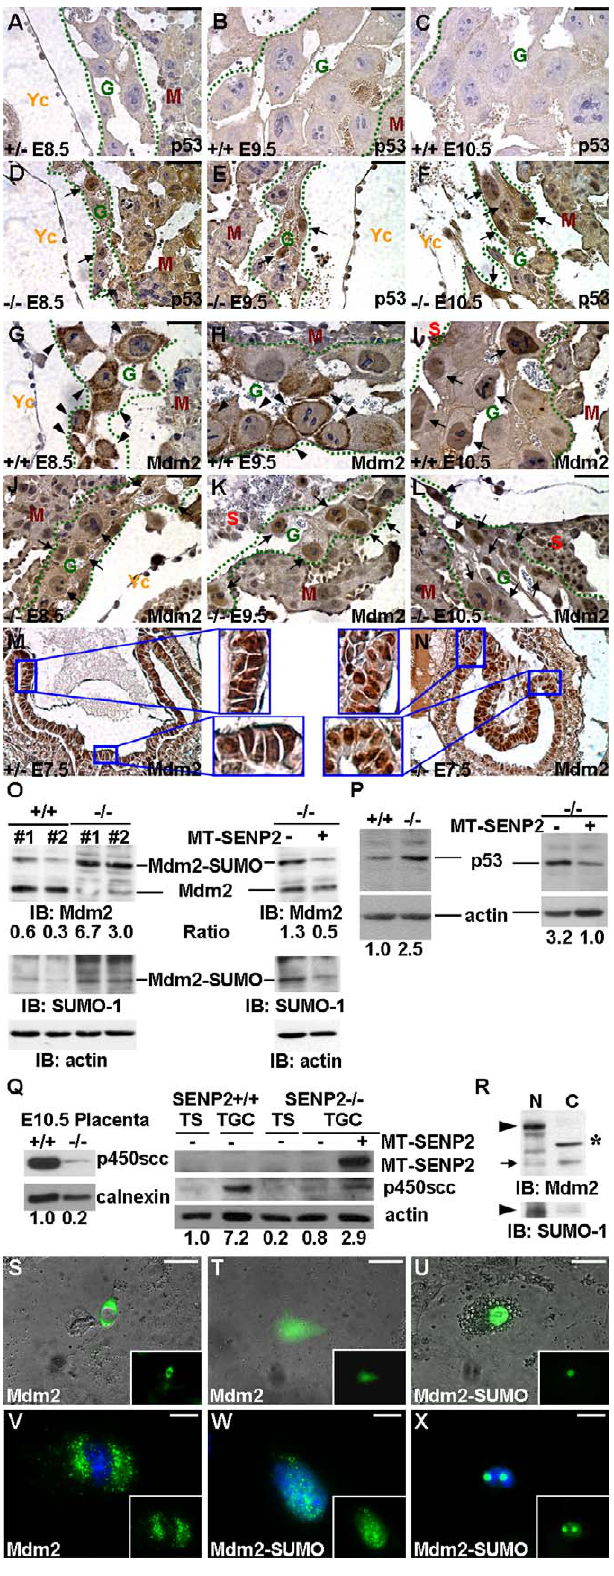
Figure 9. SENP2 Regulates the p53–Mdm2 Circuit During Trophoblast Development (A–N) Sections of the E7.5 (M,N), E8.5 (A,D,G,J), E9.5 (B,E,H,K) and E10.5 (C,F,I,L) SENP2 þ / þ or SENP2 þ /– (A–C,G–I,M) and SENP2 –/–